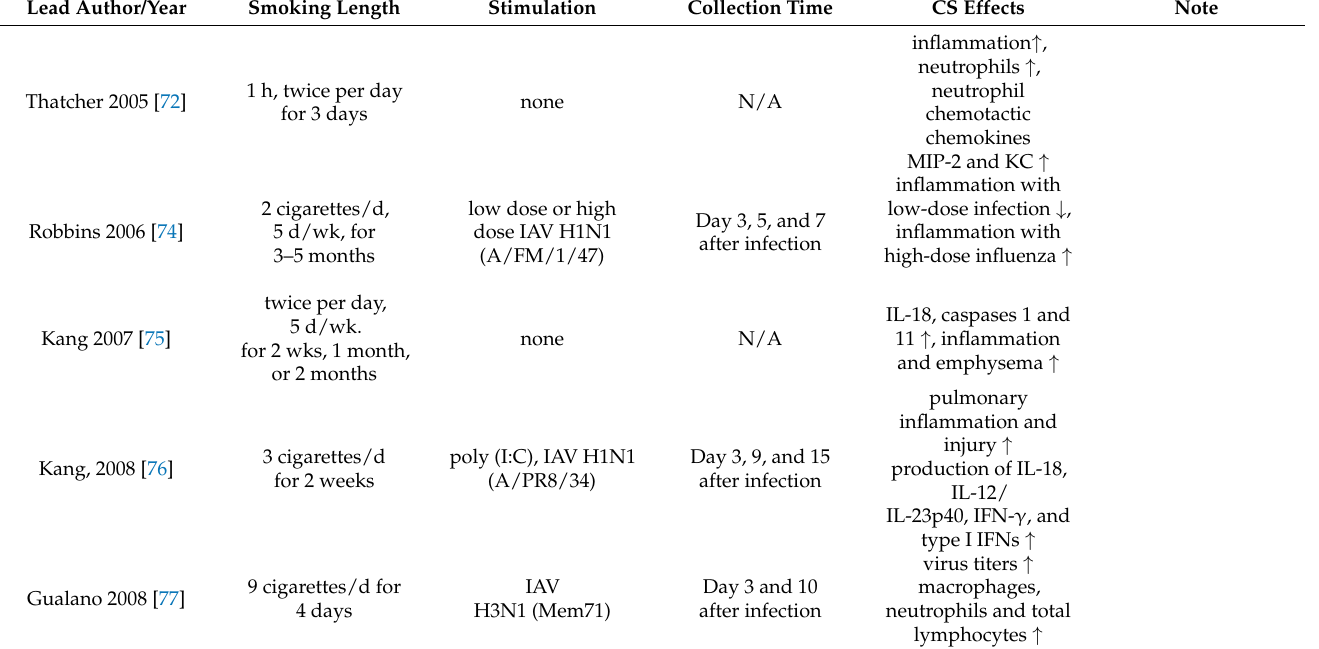
Table 1. Summary of in vivo animal smoking and viral infection